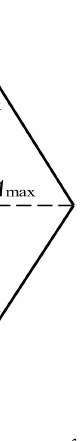
Figure 7. Diagram of the maximum rotating angle at column end.